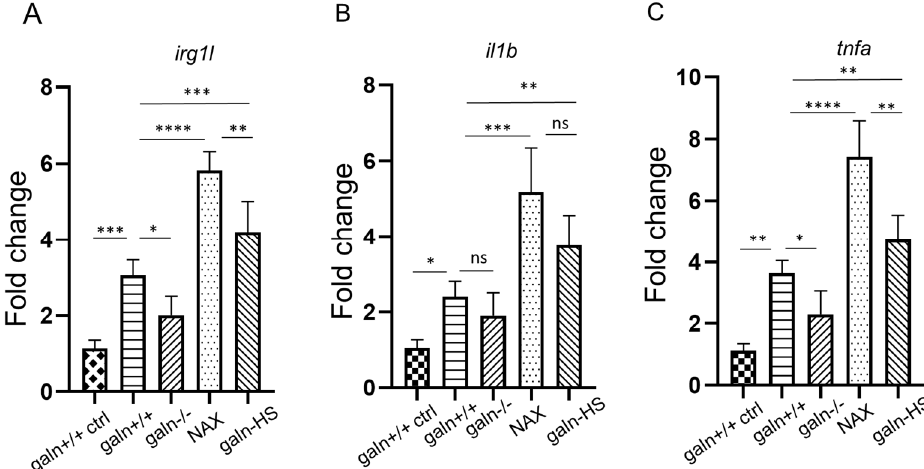
Figure 3. Quantitative PCR of irg1l, il1b and tnfa after copper sulfate incubation. ( A – C ) qPCR of irg1l, il1b and tnfa after incubation with copper sulfate in galn +/+ , galn − / − and wild-type galn +/+ treated with galanin analog NAX 5055 (NAX) and a line with galanin overexpression Tg( hsp70l:galn ) (galn-HS) groups was performed at 3 dpf. Control wild-type galn +/+ larvae ( galn +/+ ctrl) were incubated only in PBS without copper sulfate. Data and mean ± SEM were pulled from three independent experiments. * p < 0.05; ** p < 0.01; *** p < 0.001; **** p < 0.0001 (determined using ANOVA with Tukey’s post hoc test); ns, not significant.